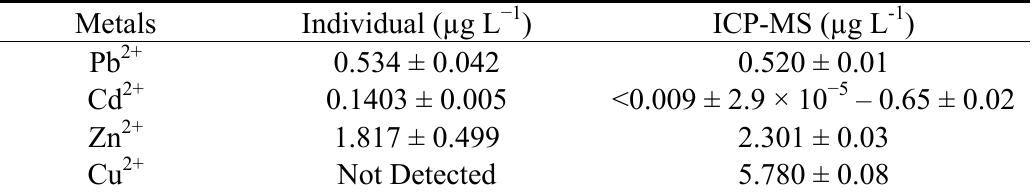
Table 5. Analysis of Lake Water using Nafion-G HgFE vs.